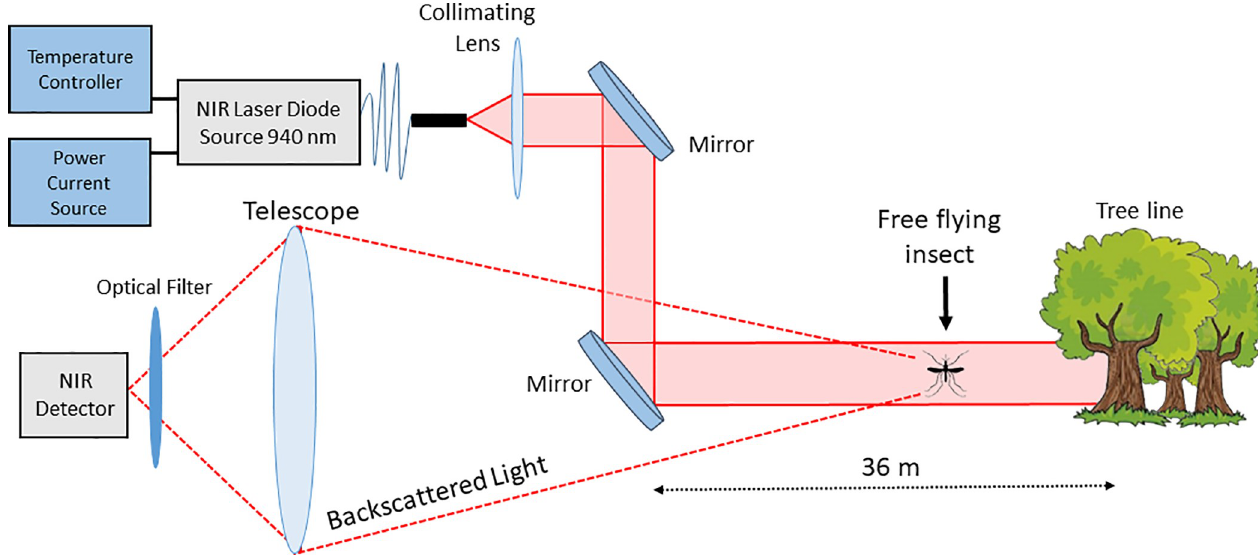
Fig 2. Optical layout of the entomological stand-off optical sensor